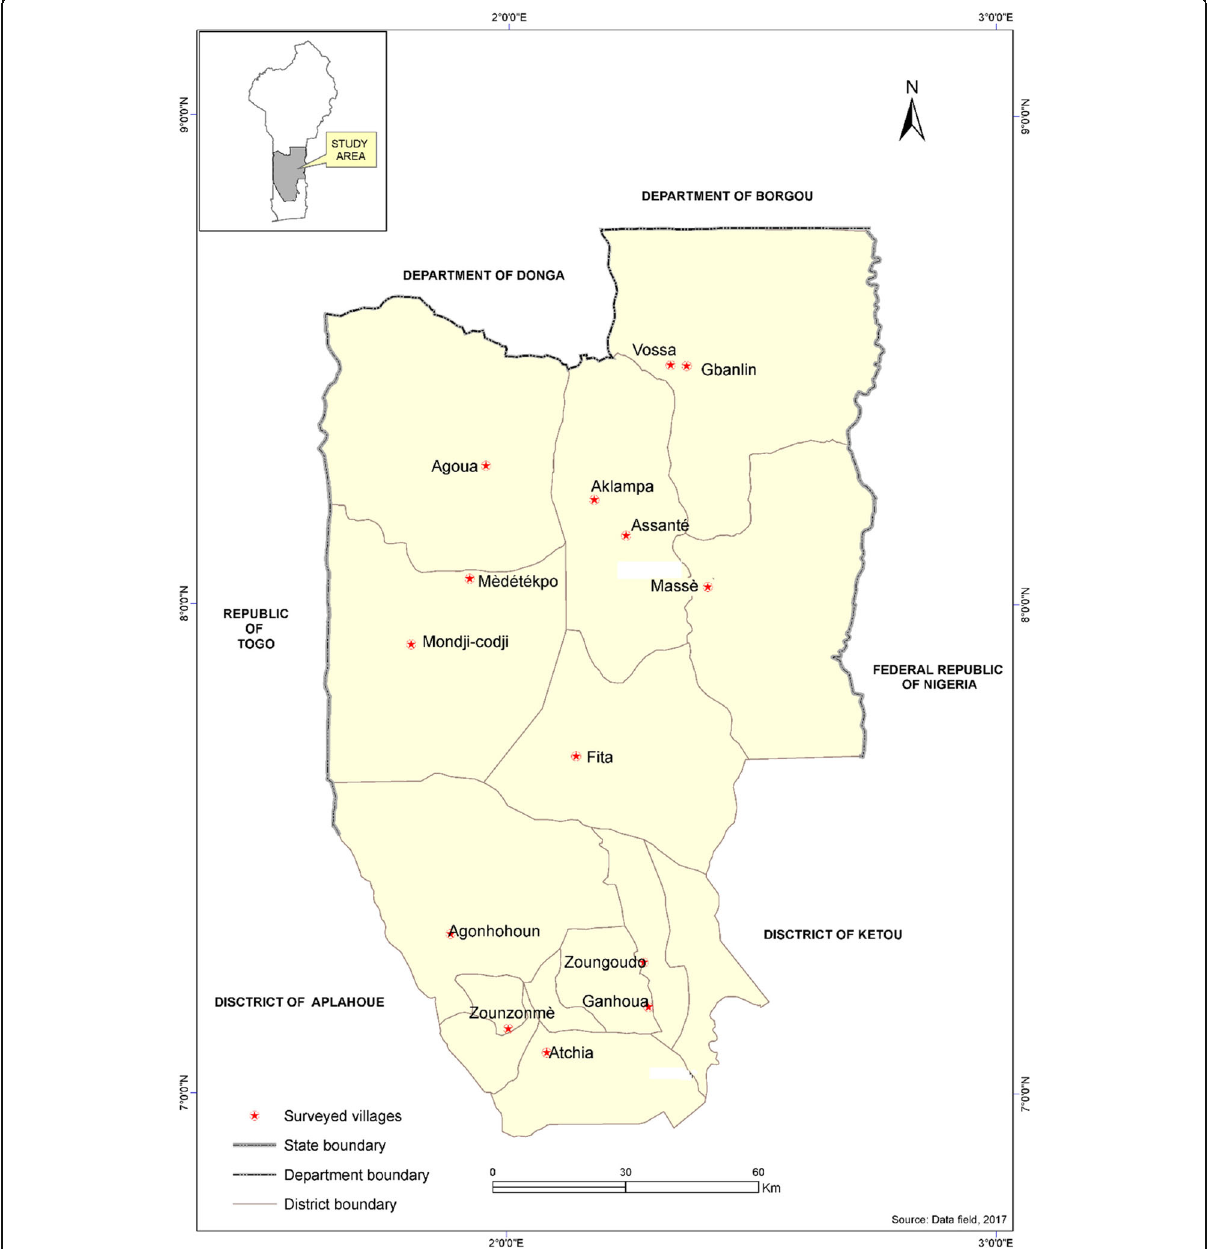
Fig. 1 Map of study area showing the geographical position of the surveyed